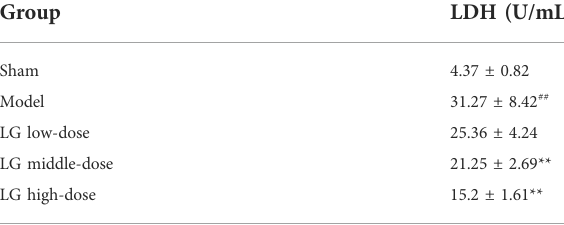
TABLE 3 Activity of LDH in BALF after LG treatment.